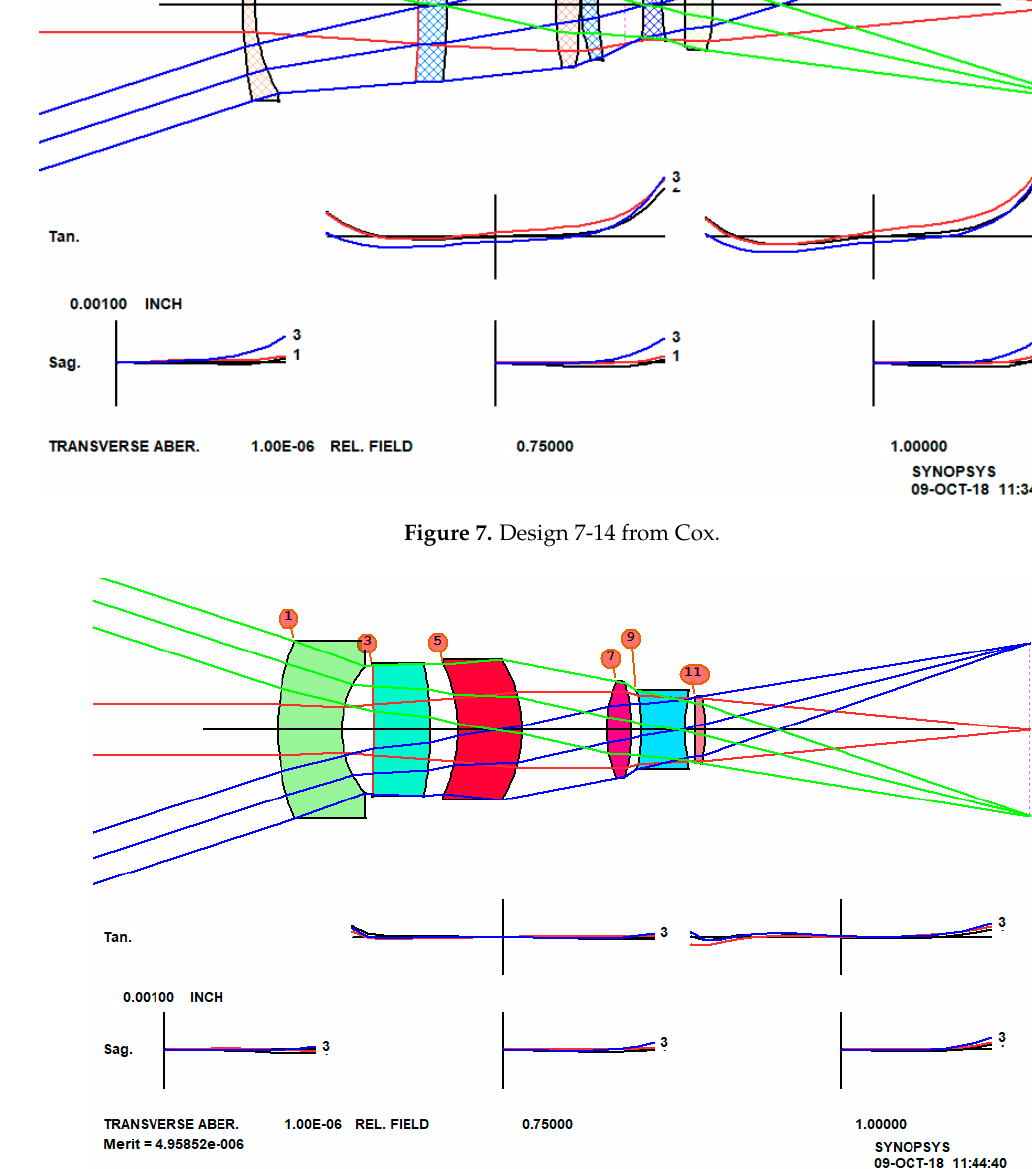
Figure 8. DSEARCH solution to the inverse telephoto lens problem.